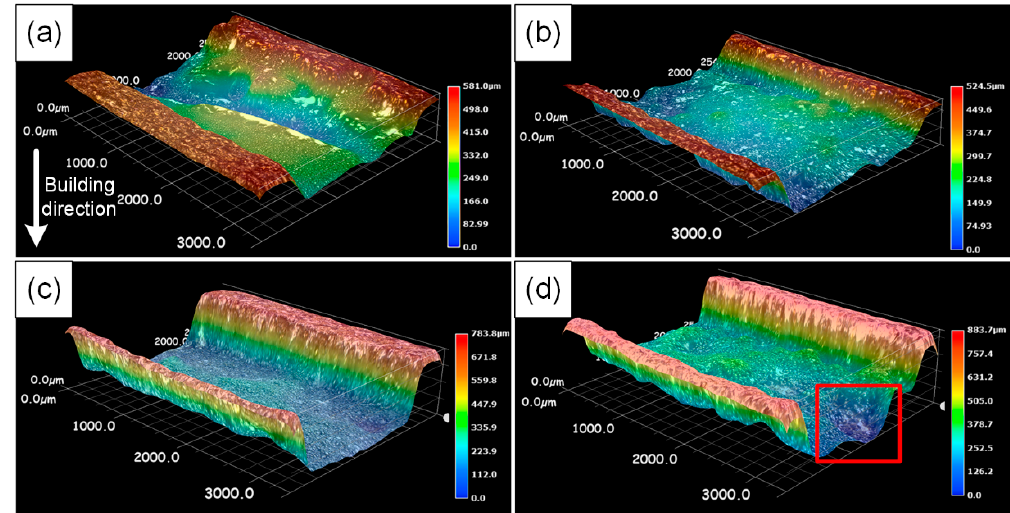
Figure 6. Morphology of lower surface of sample 1-I ( a ); 1-II ( b ); 10-I ( c ) and 10-II ( d ).